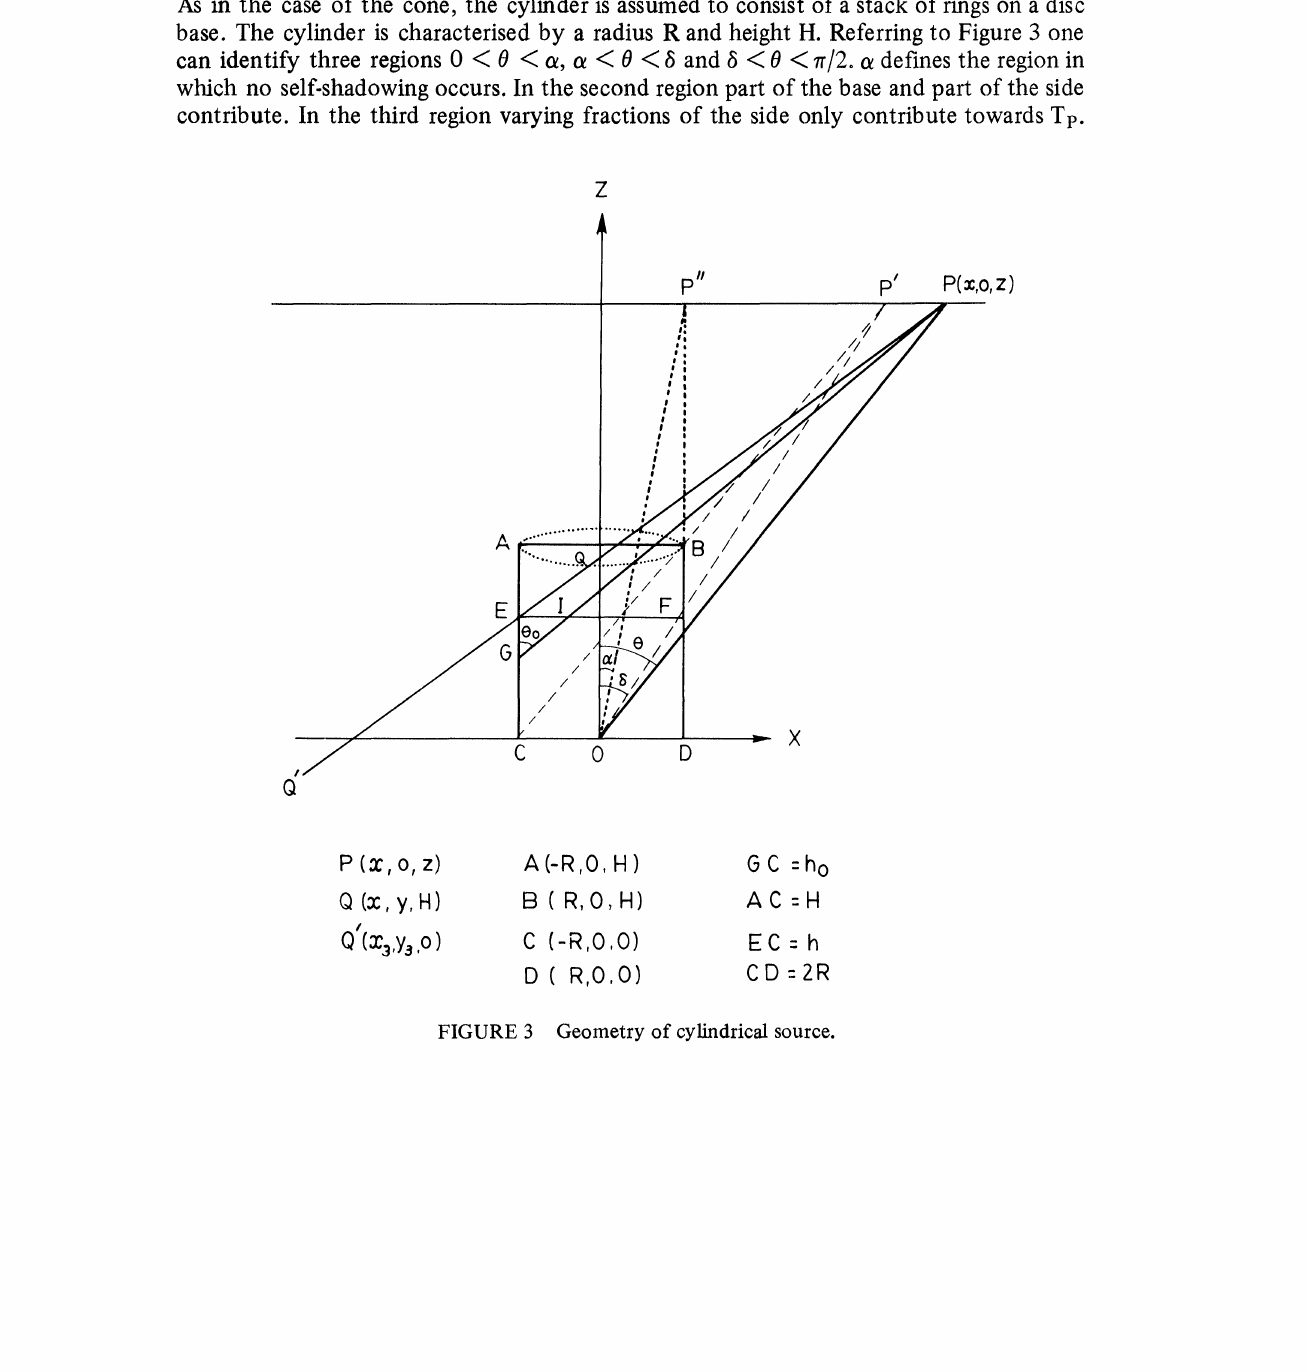
FIGURE 3 Geometry of cylindrical